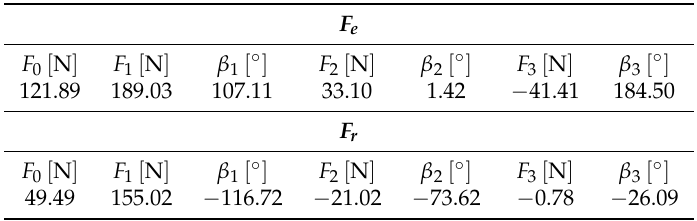
Table 1. Best fit coefficients for Equation